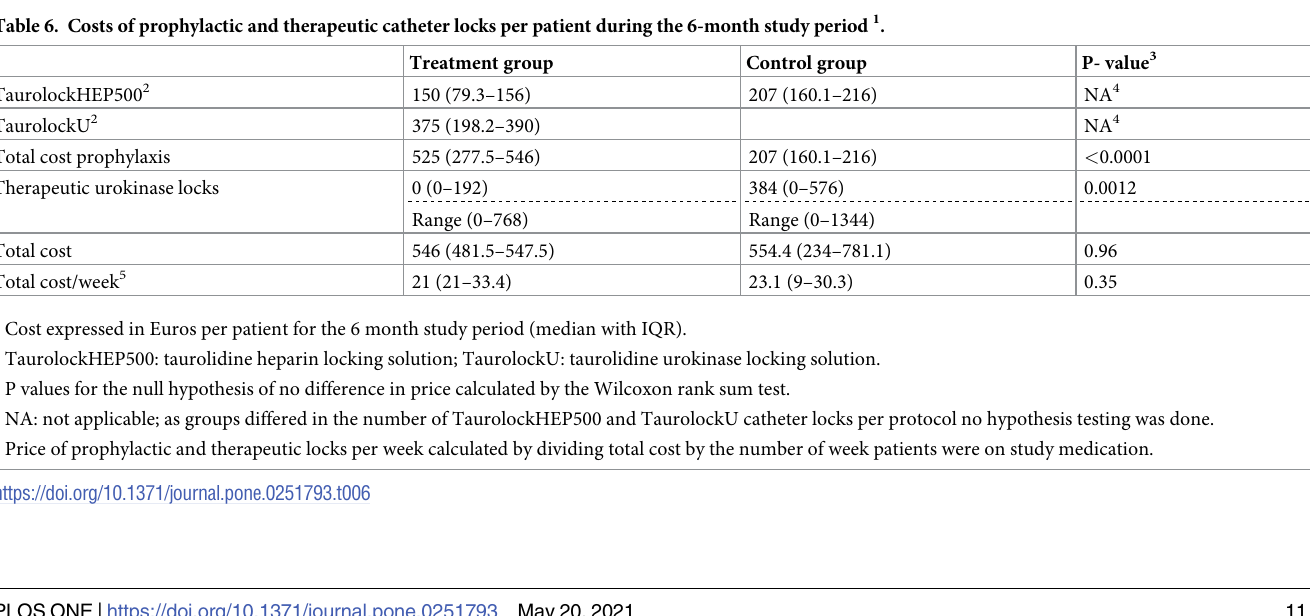
1 Number of patients with assessments of dialysis efficacy during months 1–6 in both groups: TaurolockU: 36, 31, 28, 26, 21, 15; TaurolockHEP: 31, 29, 26, 24, 21, 20. 2